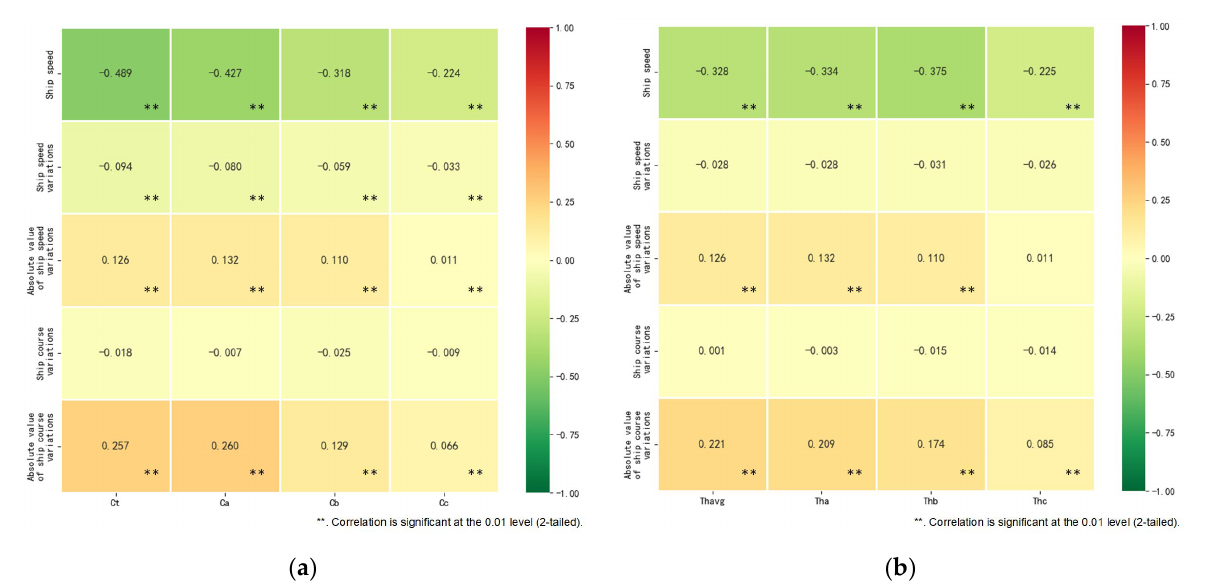
Figure 7. The correlation coefficient. ( a ) The correlation coefficient between sea ice concentration and ship movement characteristics; ( b ) the correlation coefficient between sea ice thickness and ship speed.